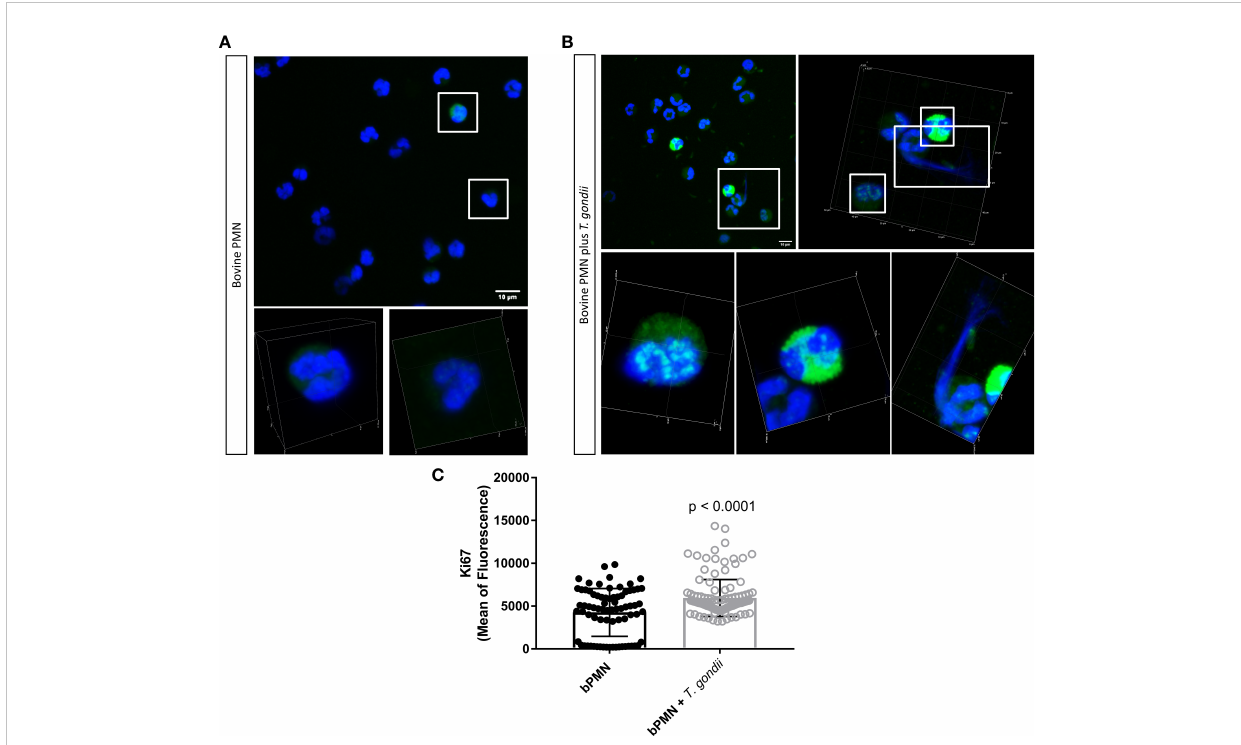
FIGURE 2 Abundance of the mitotic marker Ki-67 in T. gondii tachyzoite-exposed bovine PMN. 2 × 10 5 bovine PMN were confronted with vital 4 × 10 5 T. gondii tachyzoites (1:2 ratio) for 60 min. Samples were fi xed in PFA 4% at 60 min of interaction and the specimens were stained for Ki-67 (green channel) and DNA (blue channel; DAPI). White squares illustrate zoomed cells in the corresponding lower panel (A, B) . The abundance of Ki-67 was determined based on fl uorescence signals detected via confocal microscopy and represented as bar graph (mean ± SD). Differences in Ki-67 abundance between unstimulated and T. gondii -confronted PMN (C) were analysed by a Mann Whitney test ( a =